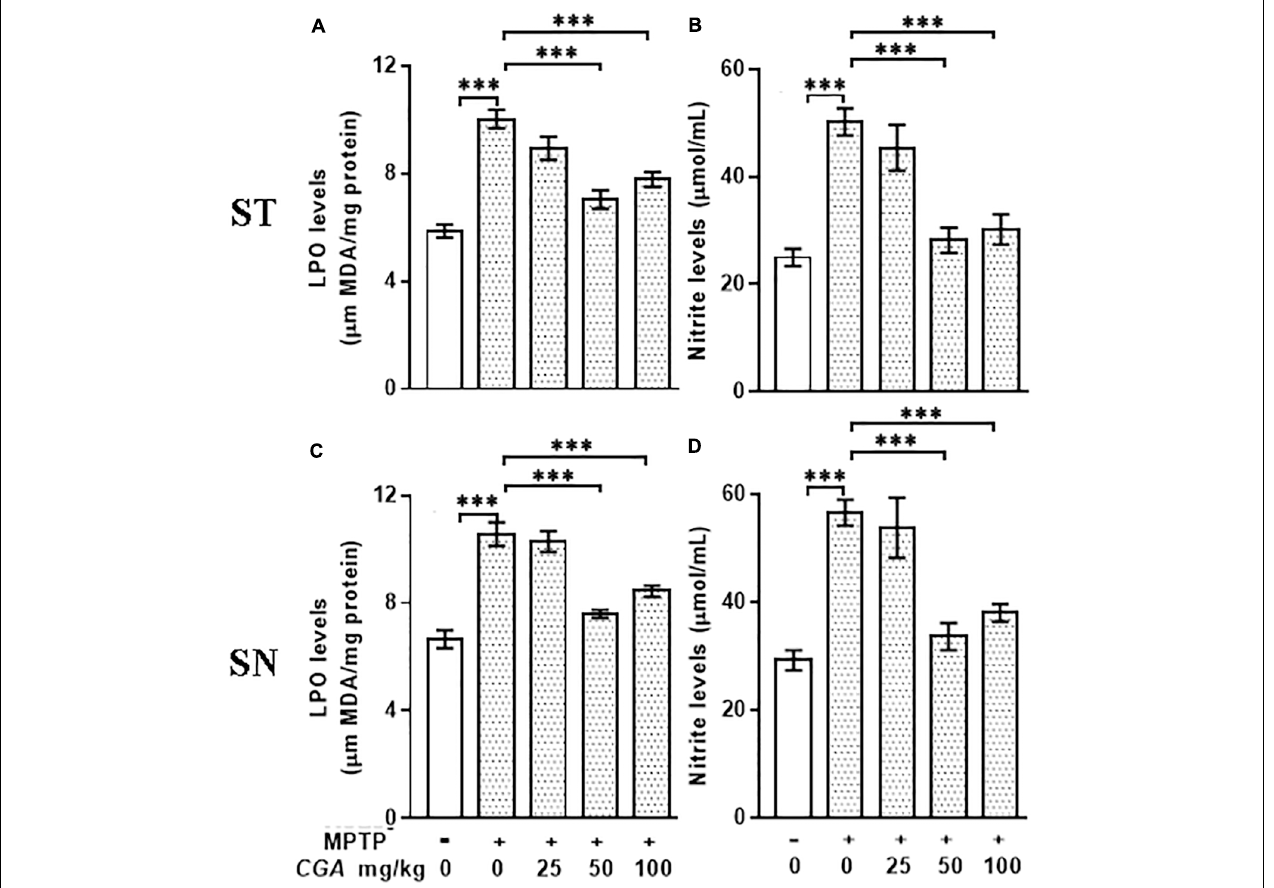
FIGURE 3 | Estimation of MDA and nitrite levels: (A–C) MDA and (B–D) nitrite levels measured in striatal and substantia nigra regions of brain. MPTP injection caused significant increase in MDA and nitrite levels compared with the control group. CGA treatment alleviates MPTP-induced increased levels of MDA and nitrite compared with the MPTP-injected mice. Values are expressed as mean ± SEM ( n = 6). ∗ p < 0.05, ∗∗ p < 0.01, and ∗∗∗ p < 0.001. CGA, chlorogenic acid; MPTP, 1-methyl-4-phenyl-1,2,3,6-tetrahydropyridine; MDA, malondialdehyde; SEM, standard error of